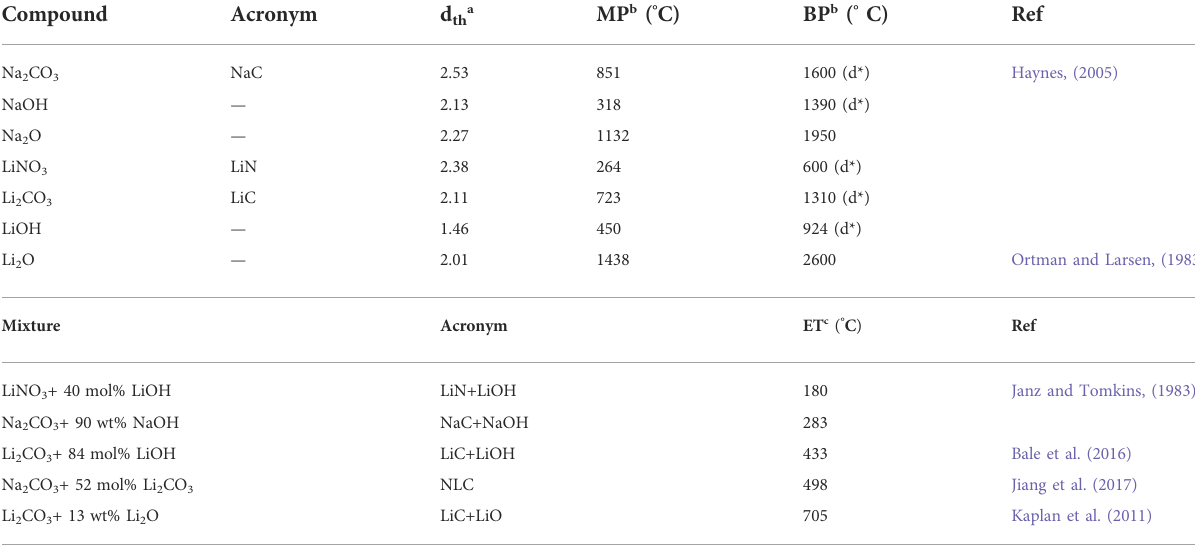
TABLE 2 List of acronyms and selected physical properties of salts, derived compounds and eutectic mixtures. Compound